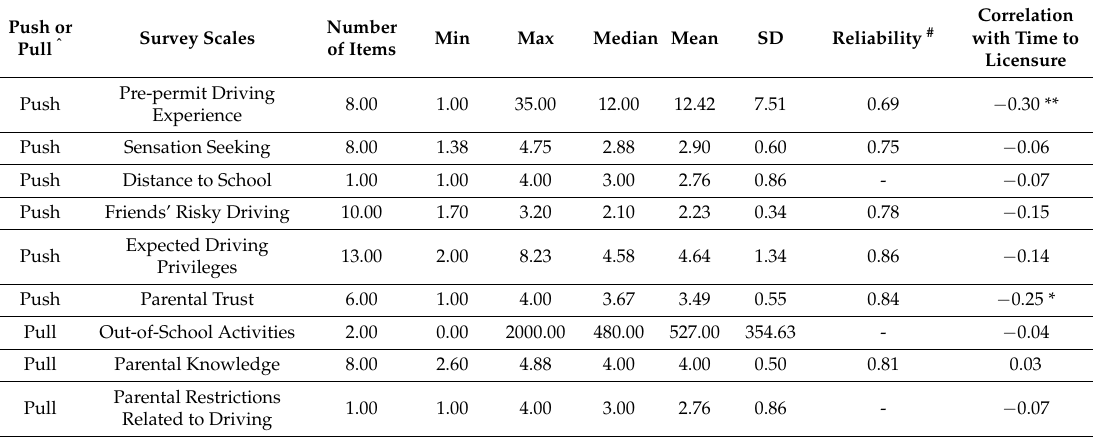
Table 2. Psychometric Properties of Survey Scales and Correlation with Time to Independent Licensure (N =